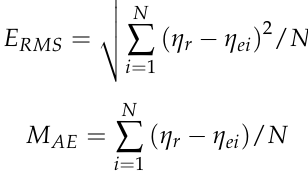
Table 1. Mean absolute error of the localization results for each component. Method